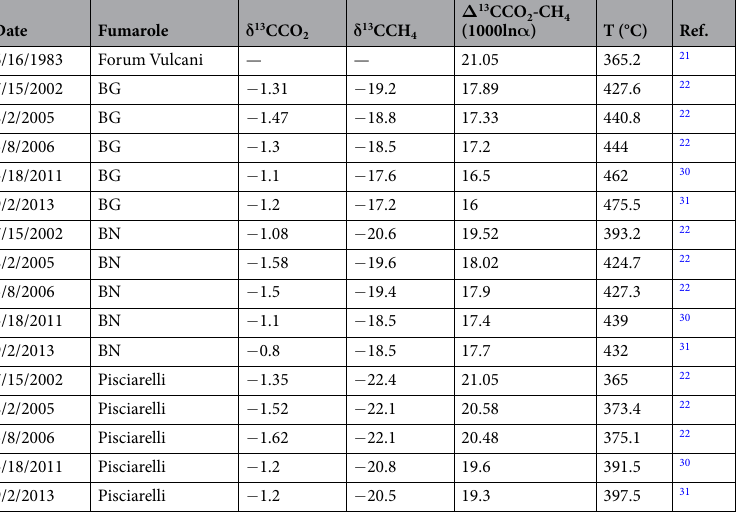
Table 1. Data used to compute the isotopic temperature from 13 C exchange between CO 2 and CH 4 (see